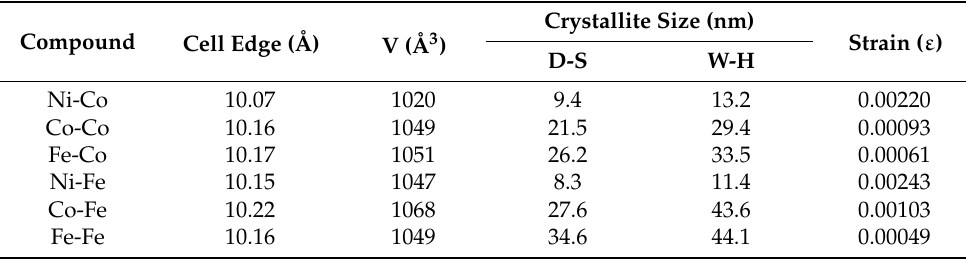
Table 2. Unit cell edge length, cell volume, crystallite size, and strain value for the studied porous